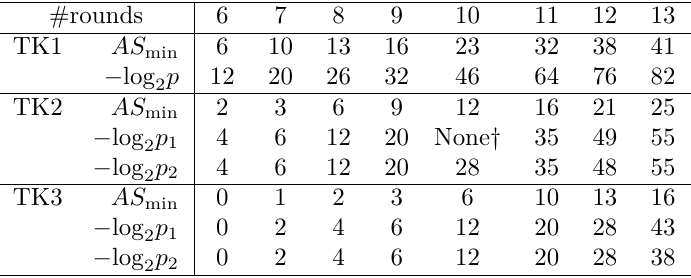
Table 6: Bounds on the number of active Sboxes and probability of trails in SKINNY-64 under related-tweakey models